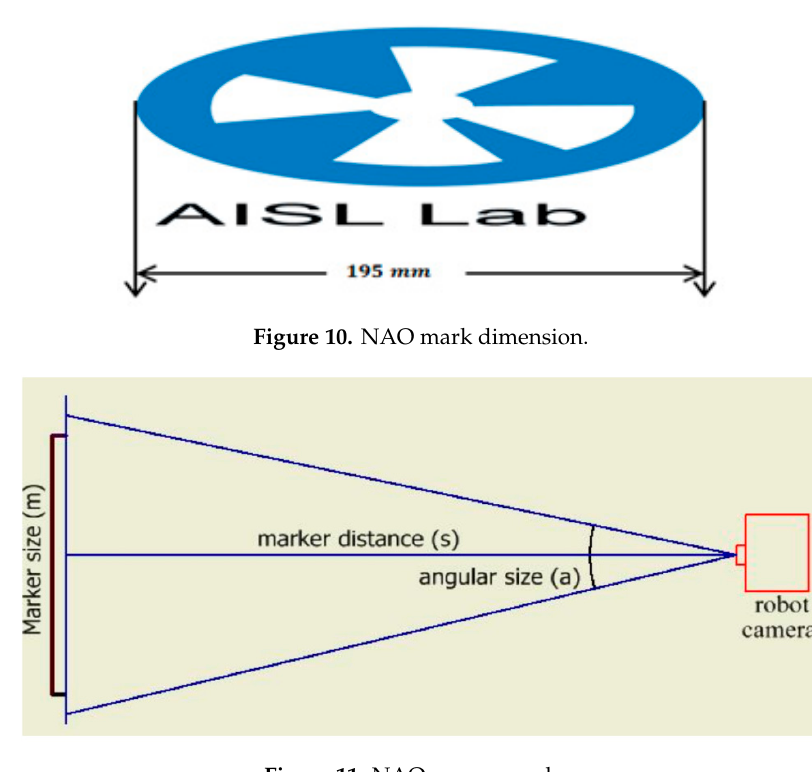
Figure 11. NAO camera angles